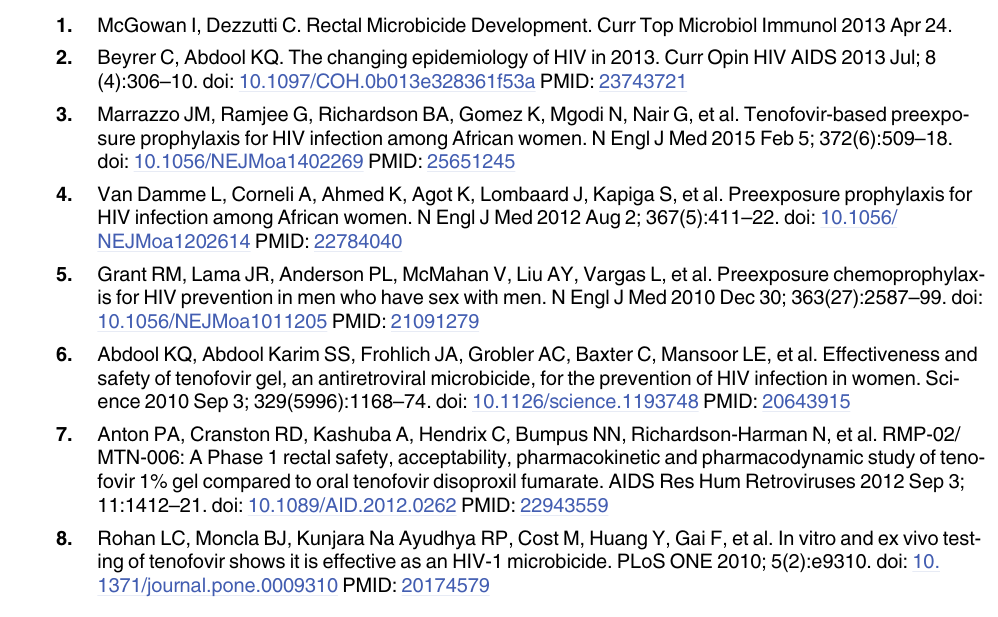
S1 Table. Complete flow cytometry data. (DOCX) S2 Table. Complete anaerobic microflora data. S3 Table. Complete facultative microflora